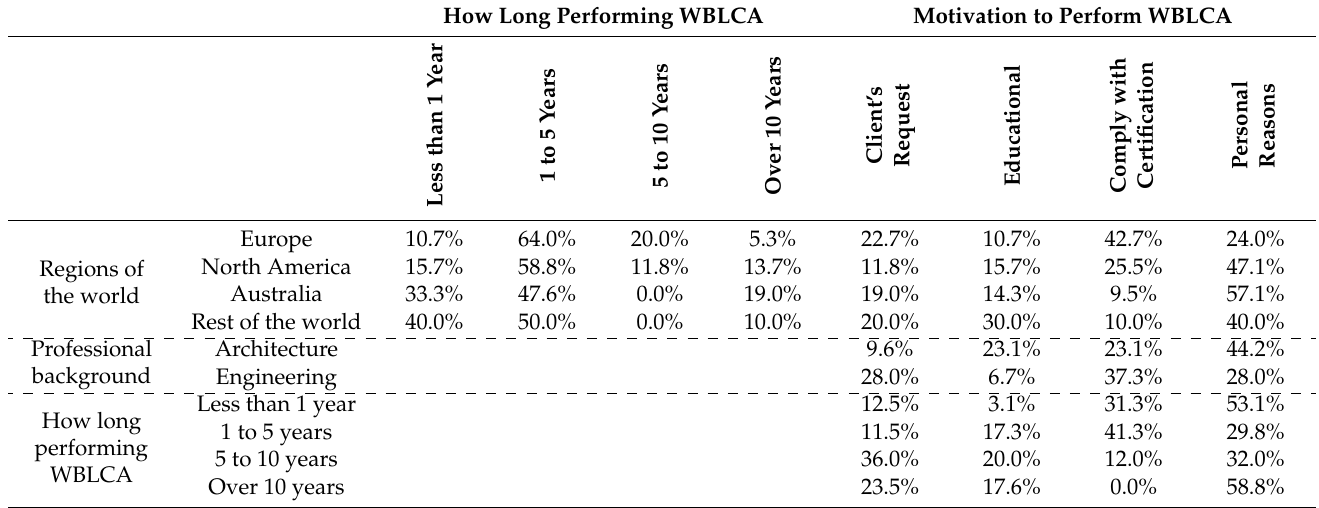
Table 5. Relationship between the groups of independent